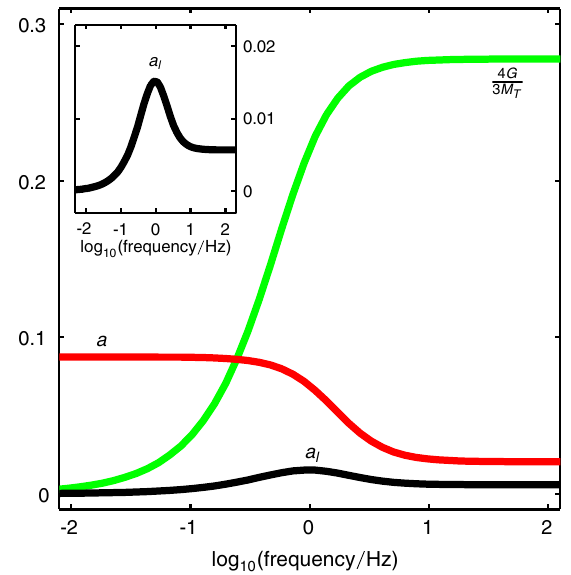
FIG. 1. Sketch of overlapping relaxations (absolute values) of Þ (green line) and the thermomechanical coupling 4 G= ð 3 M T K =c a ¼ T(cid:3) 2 (red line). The longitudinal coupling constant T p p ¼ ð c (cid:2) c Þ =c a (black line) is the product of those two l l p p frequency-dependent functions. Near the crossing of the two and c is generally curves, the difference between c l p